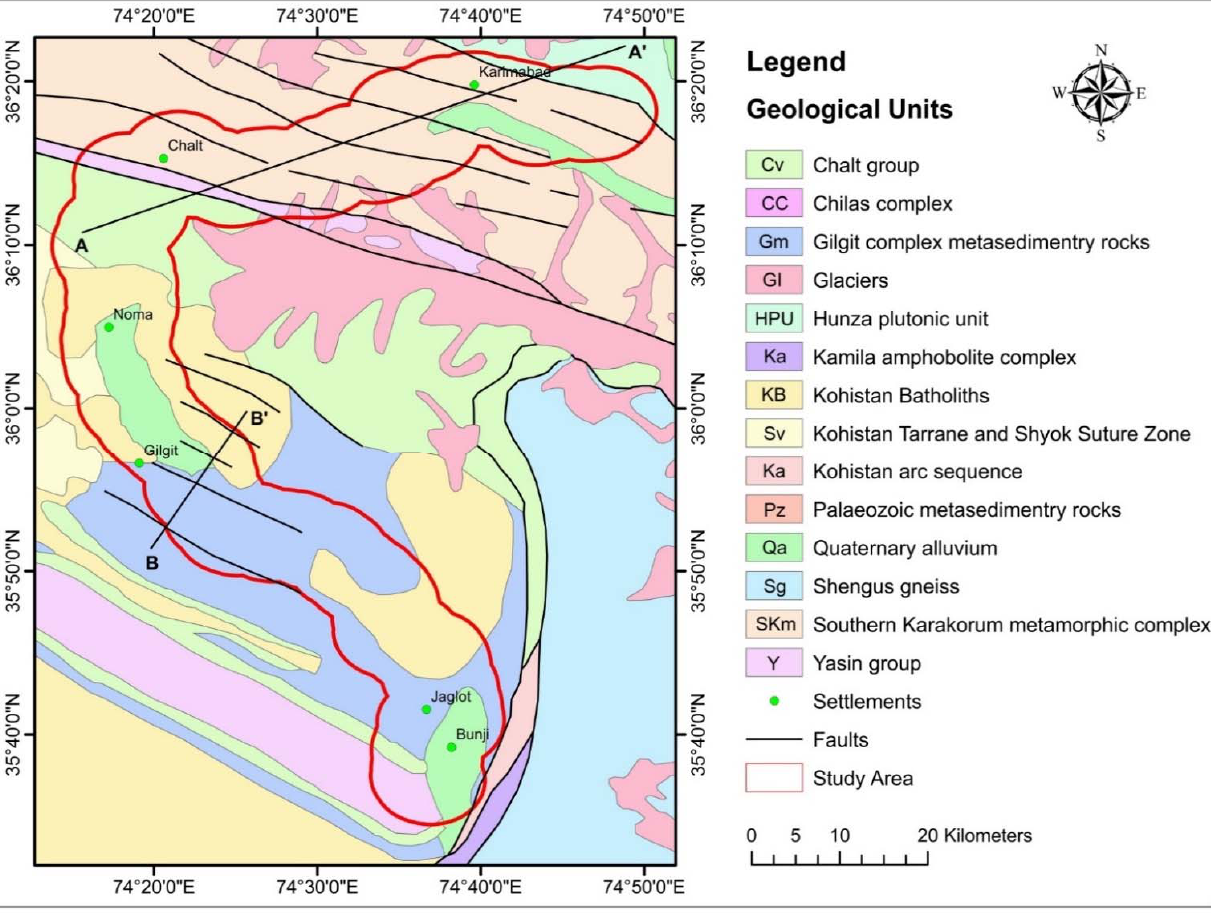
Figure 2. Regional geological map of the research area .